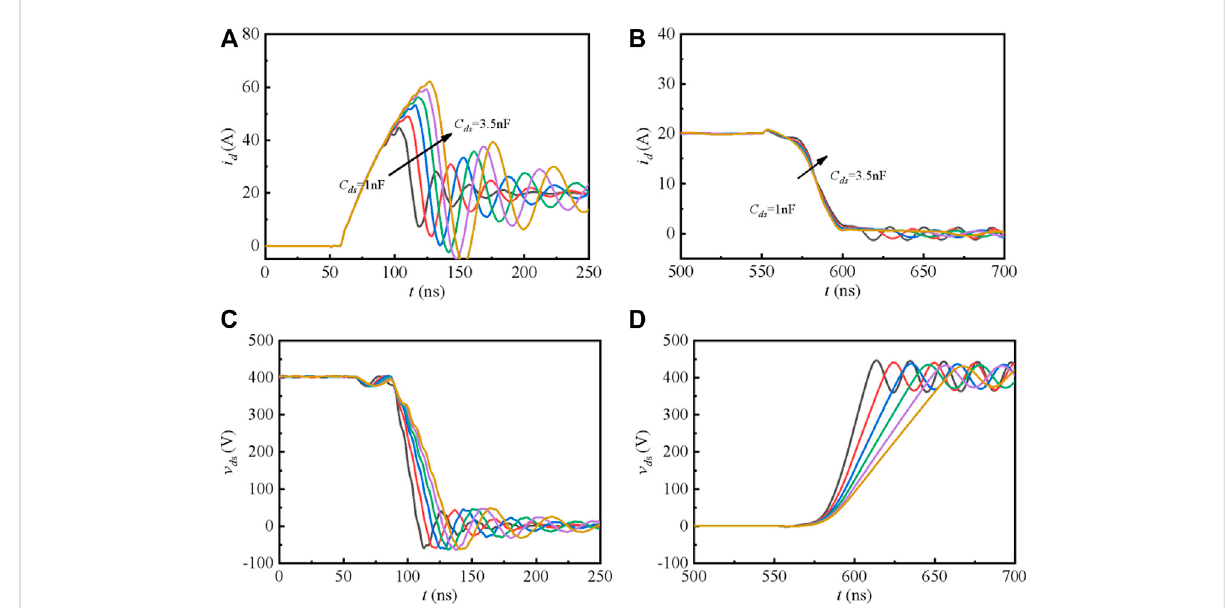
FIGURE 10 In fl uence of C ds on the switching behavior of the SiC MOSFET. (A) Turn-on i d . (B) Turn-off i d . (C) Turn-on u ds . (D) Turn-off u ds .